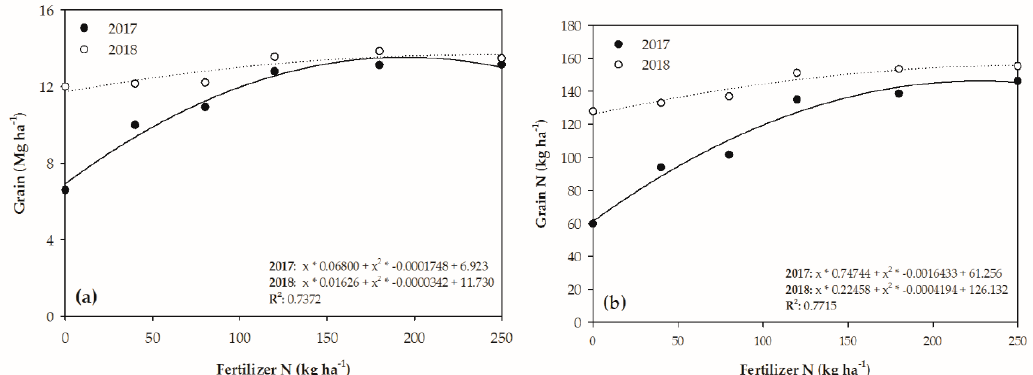
Figure 3. ( a ) response of grain yield and ( b ) grain N to fertilizer nitrogen (N) rate for second-year maize in 2017 and 2018.